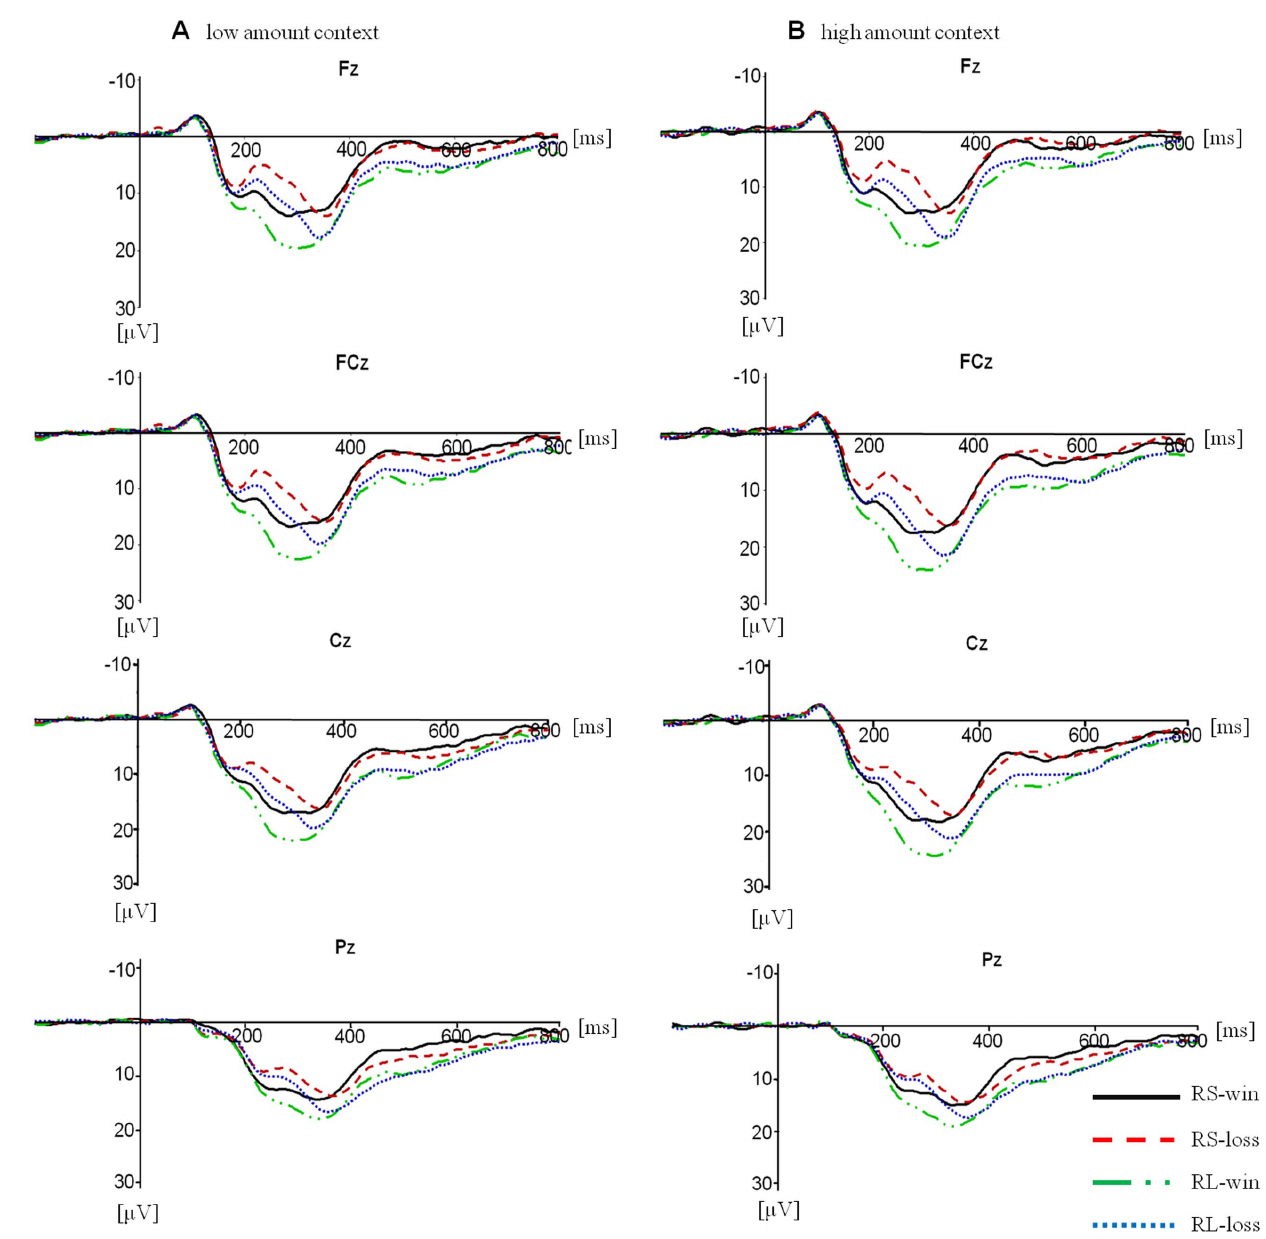
Figure 3. Grand average ERPs at Fz, FCz, Cz and Pz for four kinds of results in the low amount context (A) and in the high amount context (B). RS, relatively small; RL, relatively